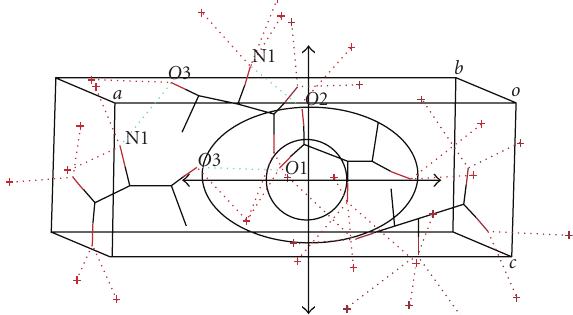
Figure 20: Thermal expansion projection of L-threonine along a - axis.